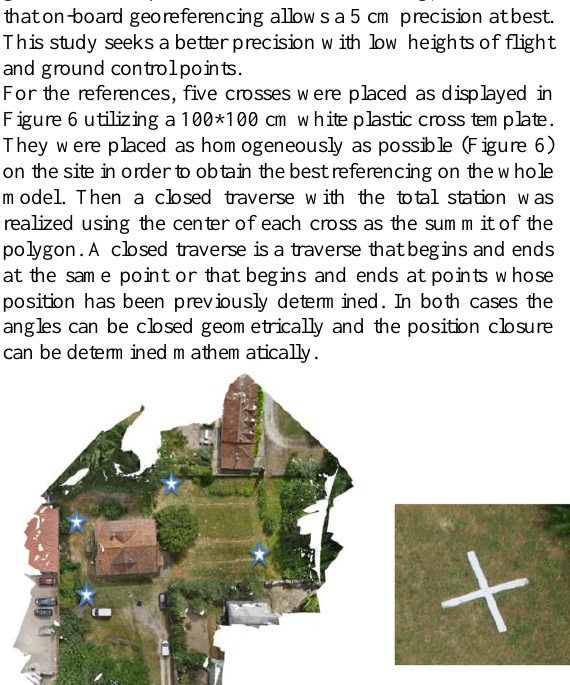
Figure 6: Reference points position.